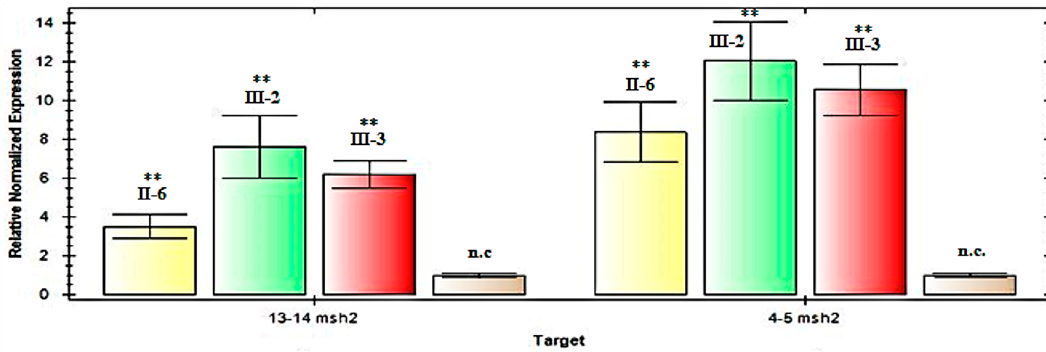
Figure 3. q-Real-Time PCR analysis of the MSH2 mRNA in the patients with the c.*226A > G variant. Relative expression, calculated using the comparative Ct method, of MSH2 cDNA, including fragments 13–14 and 4–5, normalized to β -glucuronidase levels, in patients II-6, II-2, III-3 and in an average of three normal controls (n.c.). The results represent the average of three independent experiments ± standard deviation. Patient numbering corresponds to that adopted in the pedigree, as shown in Figure 1. **Statistical significance was determined by one-way ANOVA ( p -values were < 0.05).